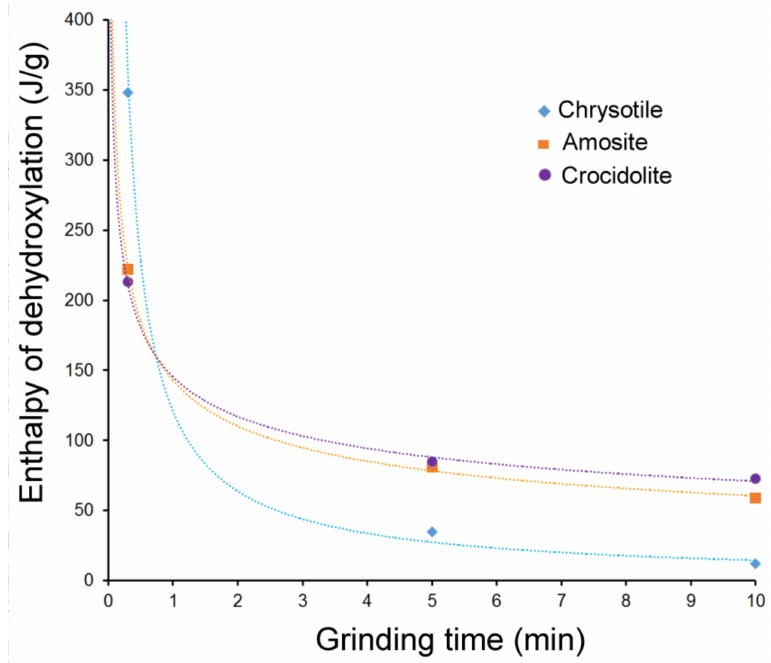
Figure 5. Change in enthalpy of dehydroxylation ( ∆ H dehy ) as grinding time